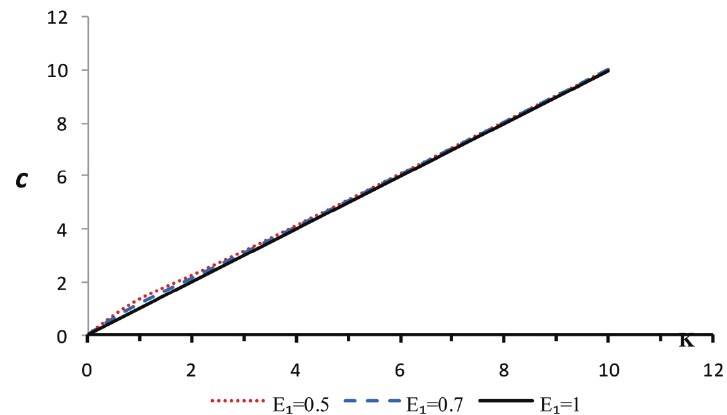
Fig. 6. Variations of c in terms of K for different values E 1